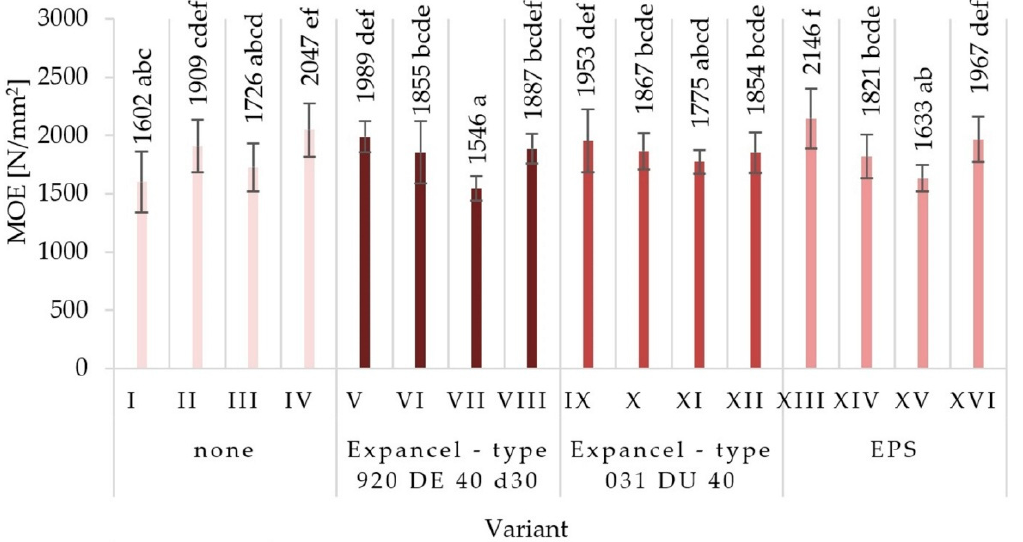
Figure 4. Modulus of elasticity ( MOE) of the particleboards produced (means and standard deviation, a, b, c, (…). Homogeneous groups were determined by the Tukey test; different letters denote a significant difference; means followed by the same letter do not statistically differ from each other).